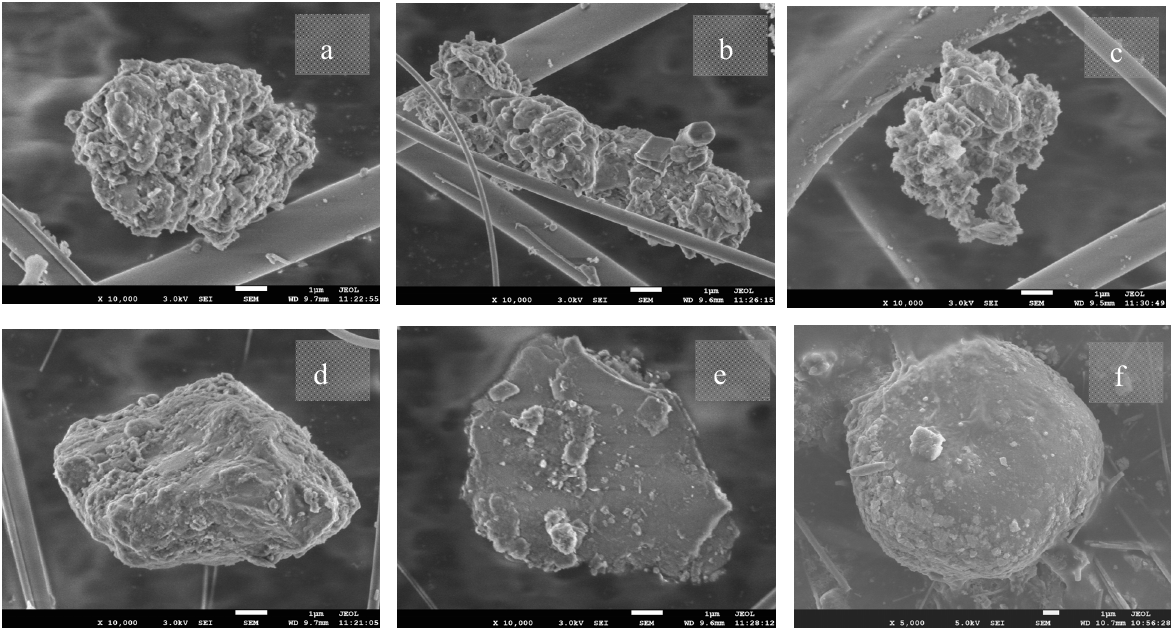
Figure 4. Scanning electron microscopy (SEM) images of atmospheric particles in PM 10 at Wutai Mount scenic spot (( a ) in the Wu Ye Temple sampling point; ( b ) in the Wu Ye Temple sampling point; ( c ) in the Yang Bai Lin Village sampling point; ( d ) in the Manjusri Temple sampling point; ( e ) in the Yang Bai Lin Village sampling point; ( f ) in the Nan Shan Temple Forest District sampling